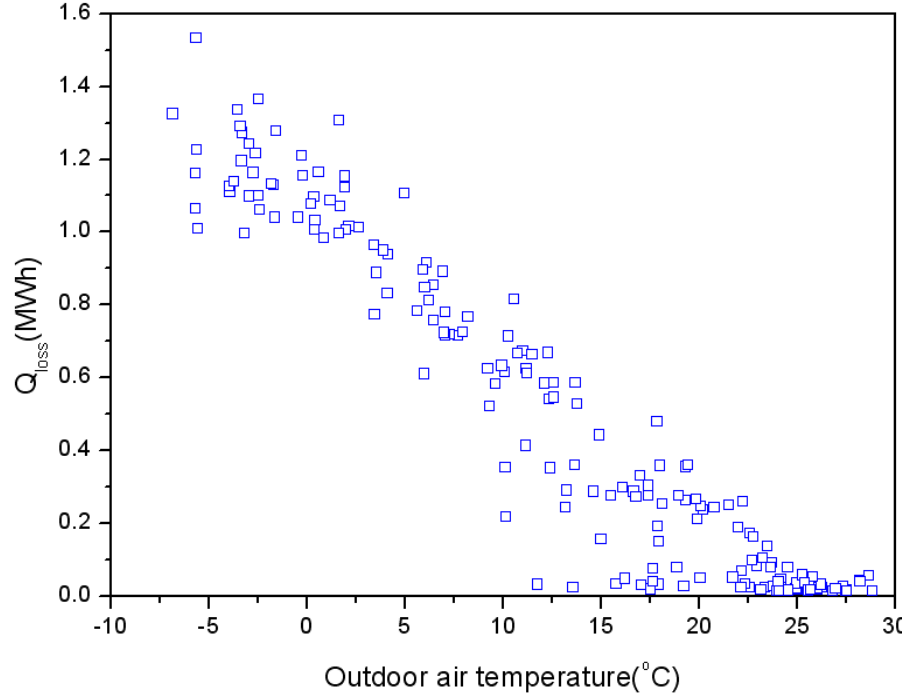
Figure 7. Heat loss rate variation of distribution line at the model apartment with respect to outdoor air